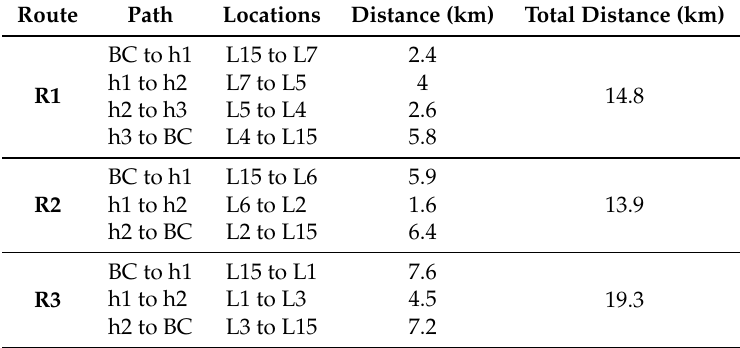
Table 7. The total distance of each route.